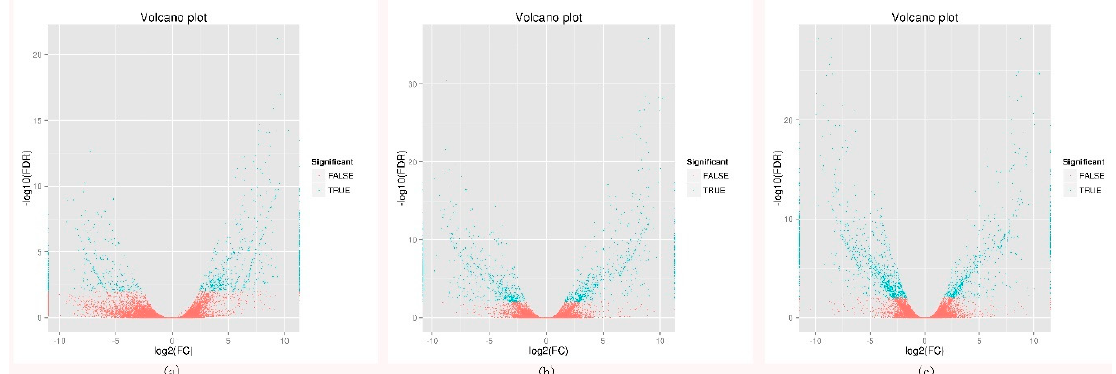
Figure 1. Volcano plot of DEGs (differentially expressed genes) in booting stage, heading stage, and flowering stage of early-flowering and late-flowering accessions. ( a ) Early booting vs. Late booting, ( b ) Early heading vs. Late heading, and ( c ) Early flowering vs. Late flowering.